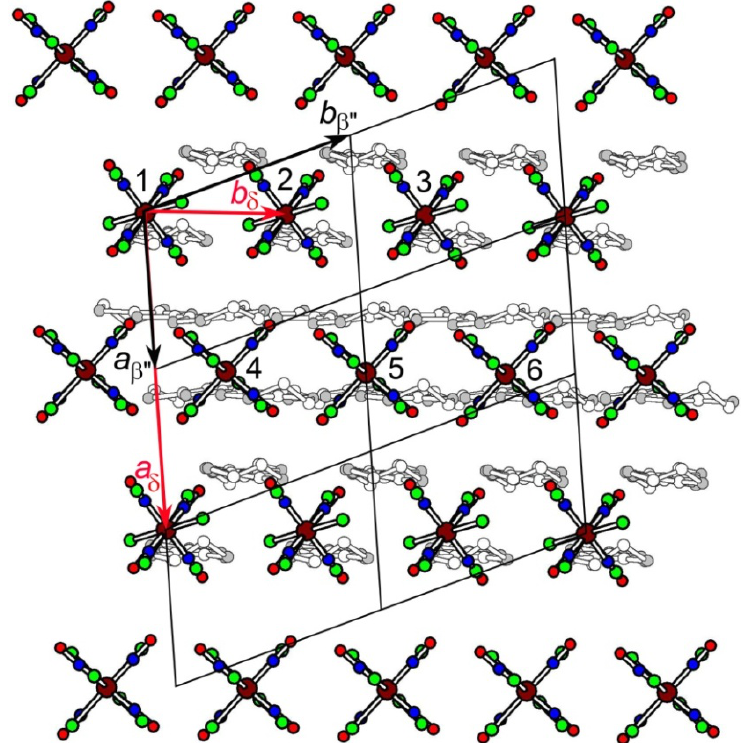
Figure 6. Anion layer in the δ -structure with neighbor donor layer in the background and scheme of the β "-lattice drawn as black solid lines. (Note, that in fact а not exactly co-directed: correct directions are shown in Figure 5b. The lattice distortion leading to deviation of the а -axis from the initial direction of the a β " simultaneously for donor and anion layers and is not shown here to avoid too much complexity in the figure. Besides, in this “idealized” orientation of the а between the anion sublattices in the δ - and β "-structures becomes more